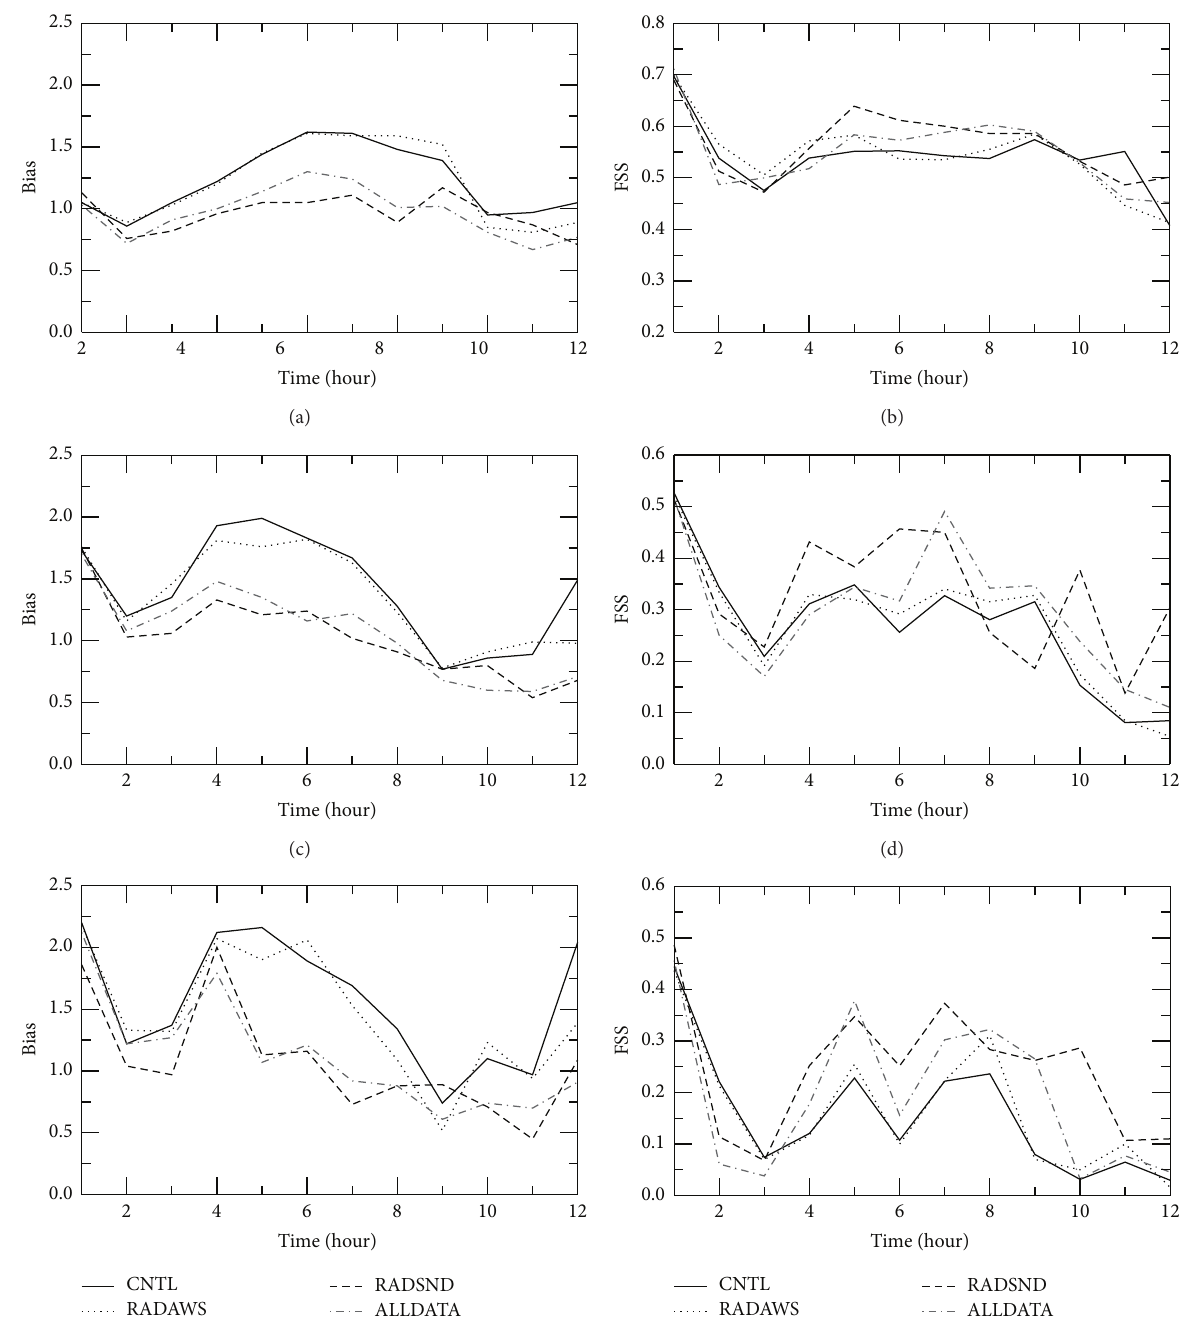
Figure 13: Bias score and FSS for hourly accumulated precipitation for case 20110715 from experiments CNTL, RADAWS, RADSND, and ALLDATA. (a) Bias and (b) FSS with the threshold of 1mm, (c) bias and (d) FSS with the threshold of 5mm, and (e) bias and (f) FSS with the threshold of